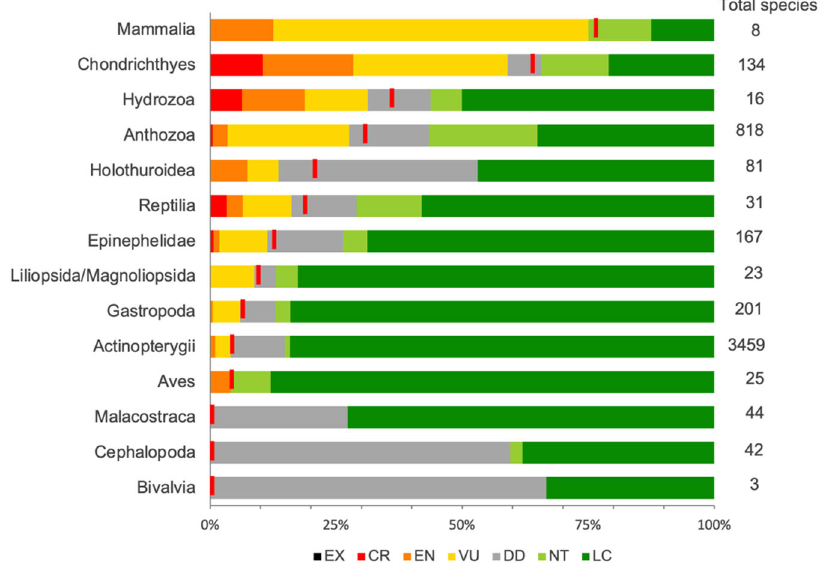
Fig. 1 | The percent of coral reef species in the IUCN Red List categories. Red lines indicate the best estimate of threat assuming all Data De fi cient (DD, grey shade) species faced a similar level of threat to the data-suf fi cient species in the